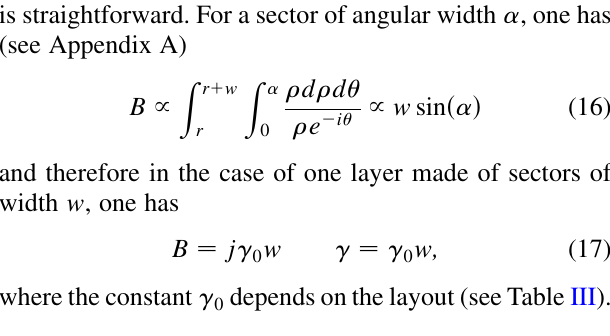
TABLE III. Values of parameter (cid:6) Number of blocks Block angles